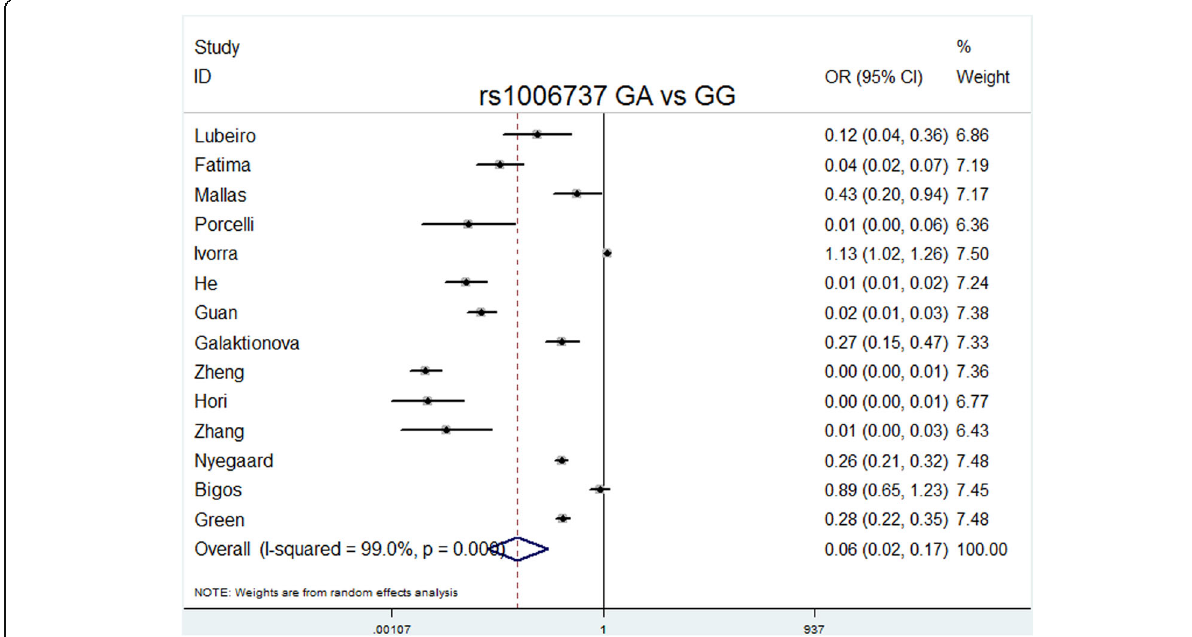
Fig. 6 Forest plot of the codominance model (GA vs. GG) for rs1006737. Significant differences between rs1006737 and the risk of schizophrenia were observed with the codominance model (GA vs. GG) (OR = 0.064, 95% CI = 0.024 – 0.169, P heterogeneity= 0.000, P = 0.000)